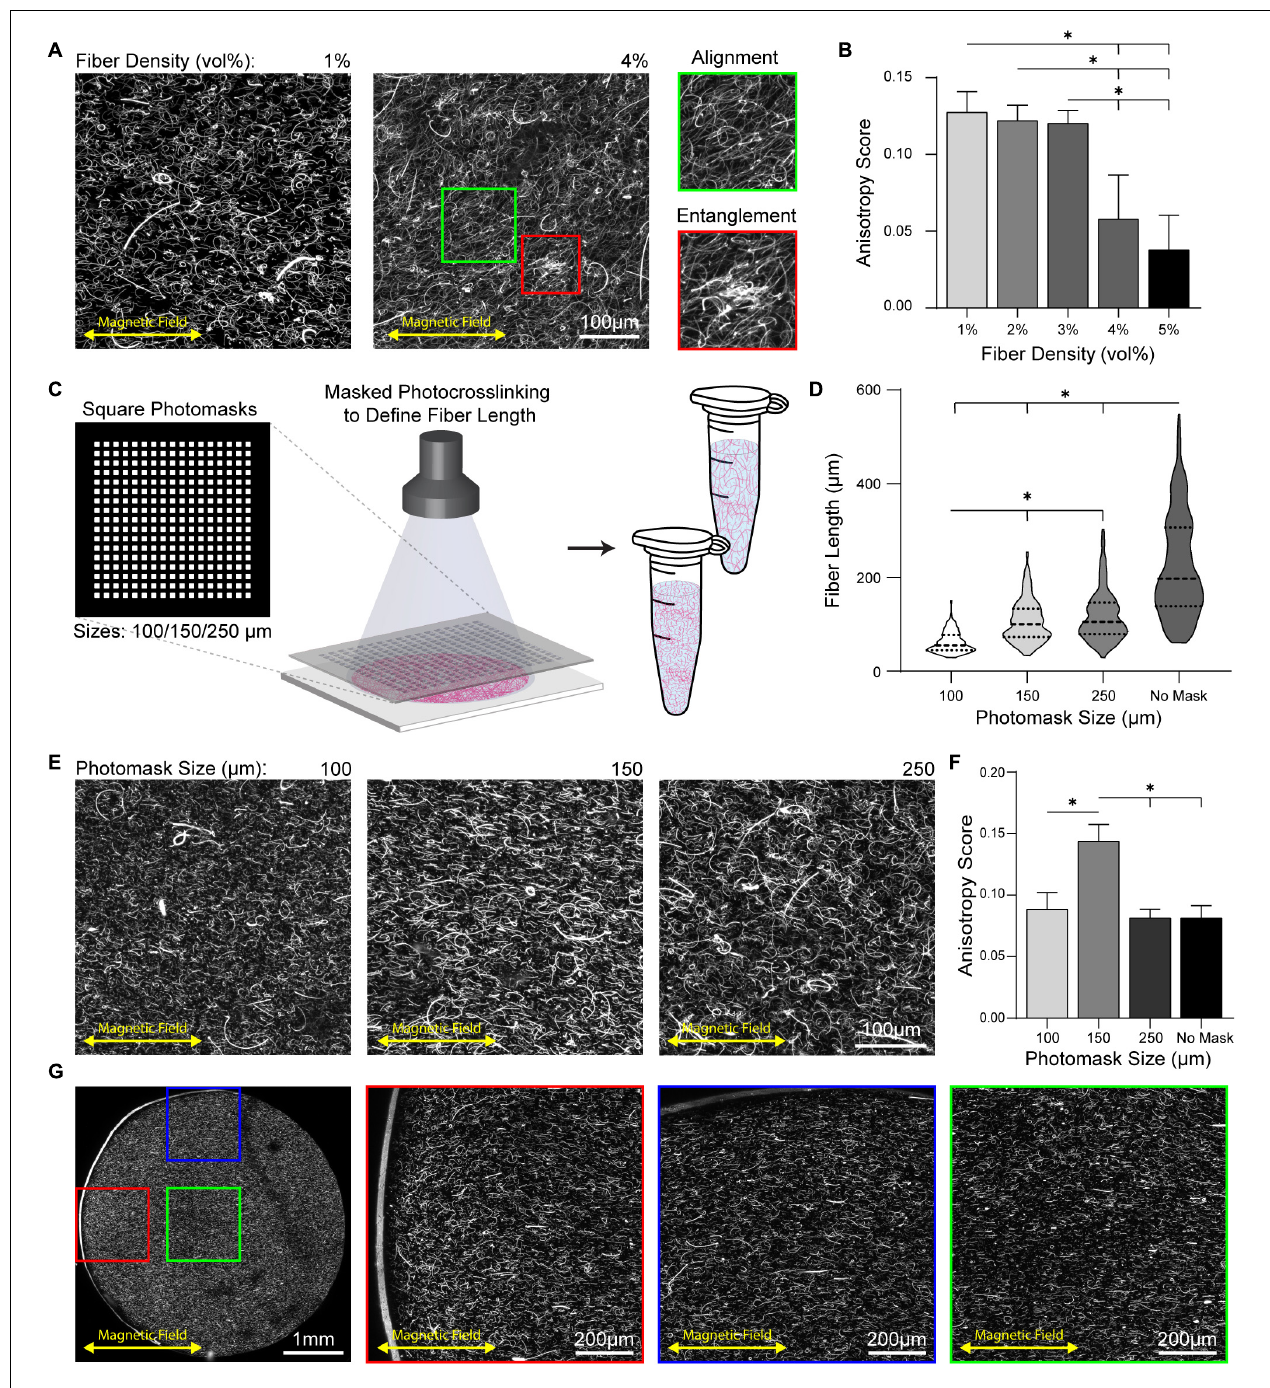
FIGURE 4 | Decreasing fiber length prevents entanglement at high fiber encapsulation density. (A) Alignment of full length fibers across a range of densities. Inserts show local regions of alignment (green) and entanglement (red). (B) Anisotropy scoring across a range of fiber densities. (C) Schematic of photomasking during photocrosslinking of fiber mats to define shorter fiber lengths. (D) Quantification of fiber length as a function of photomask size. (E) Alignment of fiber segments produced with photomasks within 3D hydrogel at 5 v/v% fiber density and (F) corresponding anisotropy scores. (G) Cross-section of a 5 mm cylindrical hydrogel composite with fibers produced by 150 µ m photomask aligned by 6 cm magnet spacing. Inserts show location regions of fiber aligned at boundaries perpendicular (red) and parallel (blue) to fiber alignment and within the gel center (green). All data presented as mean ± SD; ∗ indicates a statistically significant comparison with p <